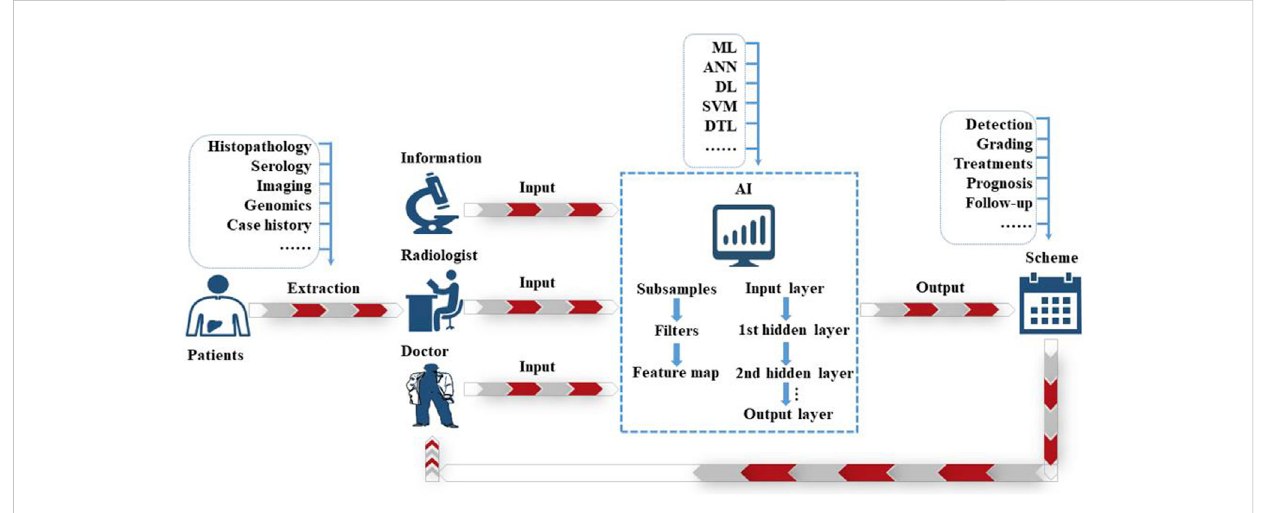
FIGURE 2 The schematic idea of AI application in the diagnosis of